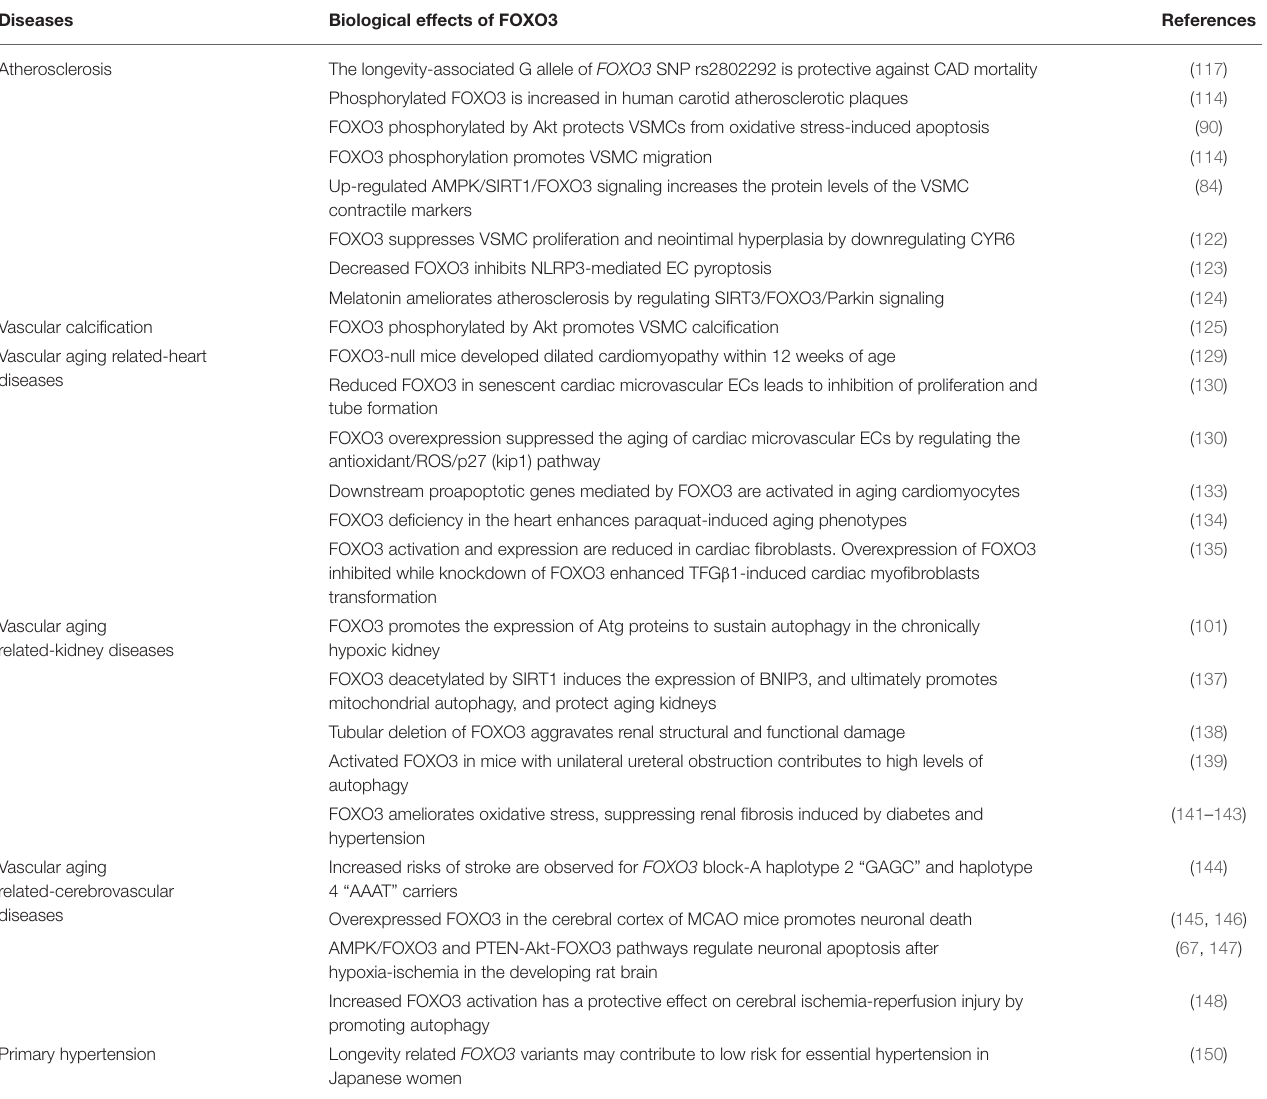
TABLE 1 | FOXO3 cellular signaling in vascular aging-related